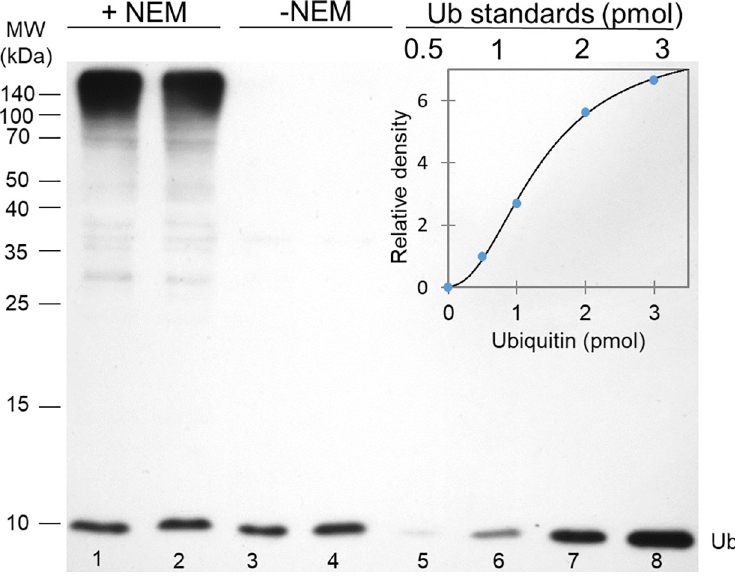
Fig 1. An immunoblot based assay to quantitate free and total ubiquitin content of whole protein extracts. In this blot, parallel pupal samples (from stage P4 pupae) homogenized in buffers F (lanes 1 and 2; +NEM) and buffer T (lanes 3 and 4; -NEM) were loaded and polyclonal anti-Ub antibody at a dilution of 1:1000 was used to detect ubiquitin. Only the intensity of the free monoubiquitin band (just below the 10 kDa mark) was determined and used for quantification. 5 μ g total protein extracts were loaded to lanes 1 and 2, while samples were diluted twofold before loading to lanes 3 and 4 to avoid overloading the monoubiquitin band. Ub standards of 0.5, 1, 2 and 3 pmol were loaded to lane 5–8 respectively, for the calibration curve. The inset shows the calibration curve that was used to calculate Ub concentrations in these samples. Band intensities were plotted against Ub standards and a regression line equation was generated by applying the four parameter curve fit model (R 2 =